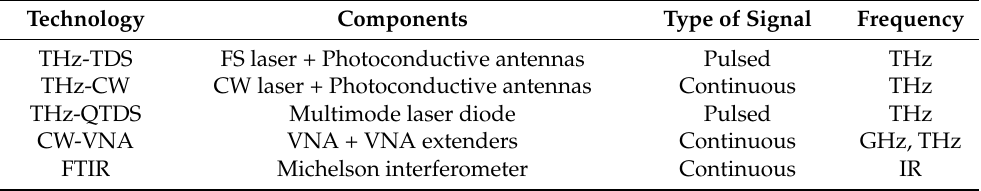
Table 1. Main characteristics of the different electromagnetic spectroscopies used in this review. Technology Components Type of Signal Frequency THz-TDS FS laser + Photoconductive antennas Pulsed THz THz-CW CW laser + Photoconductive antennas Continuous THz THz-QTDS Multimode laser diode Pulsed THz CW-VNA VNA + VNA extenders Continuous GHz, THz FTIR Michelson